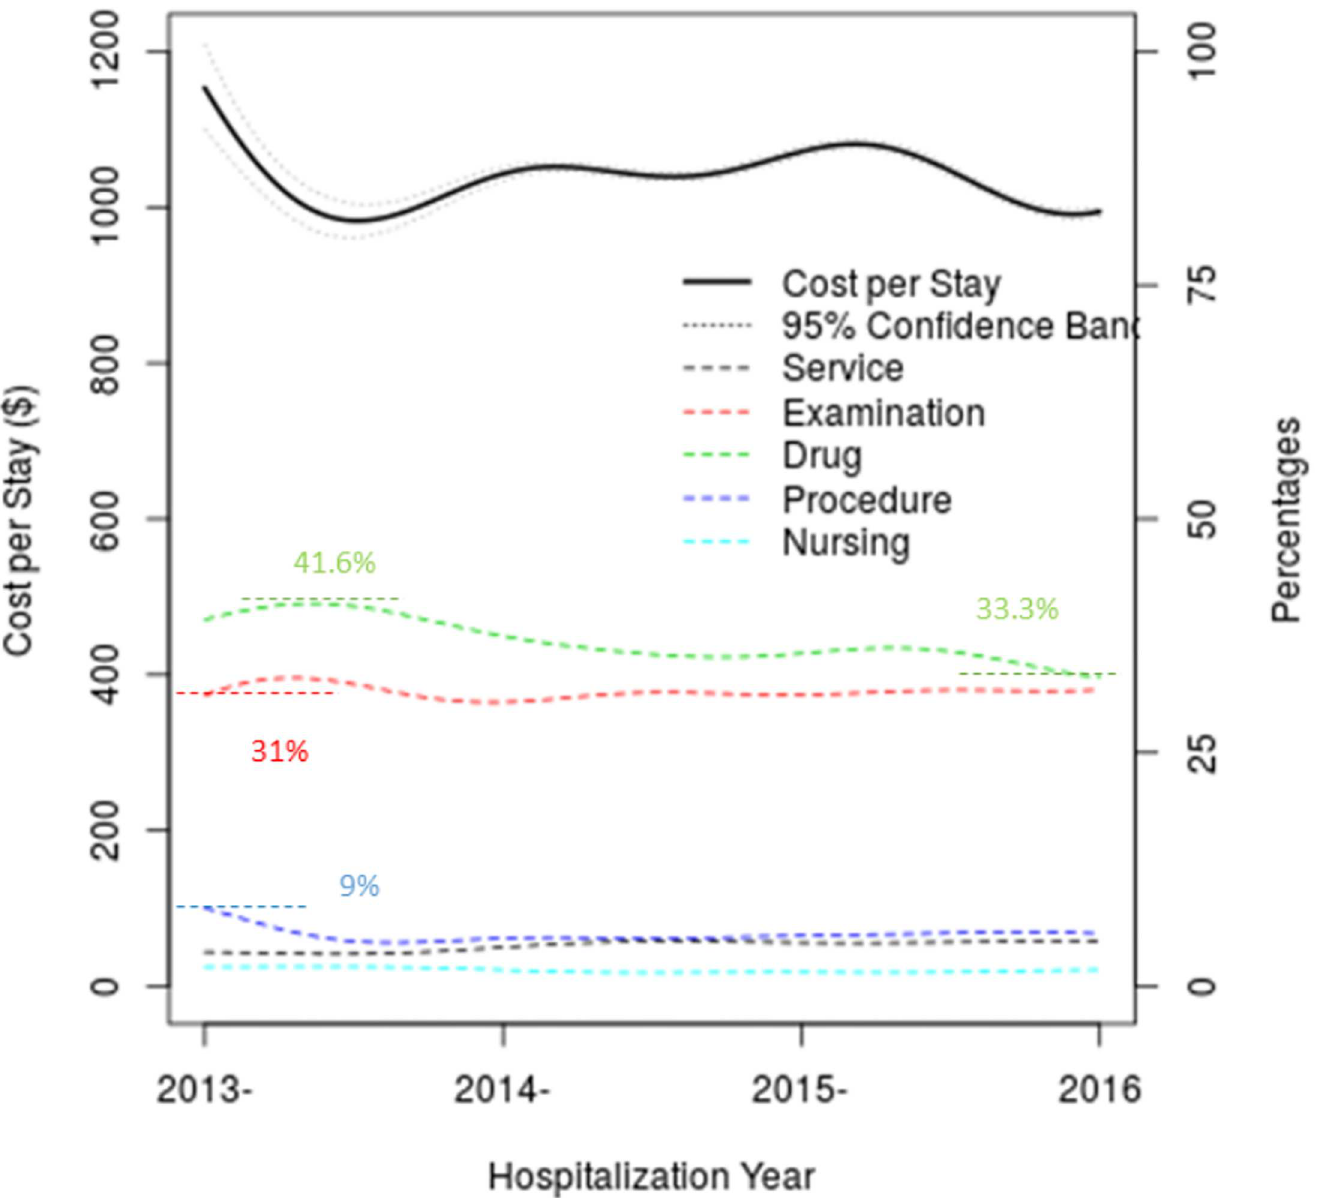
Fig 2. Compositions of cost per stay indicated by the left y-axis (from $0 to $1,200), and percentages of specific costs (services, examination, drug, procedure and nursing) by the right y-axis (from 0% to 50%).